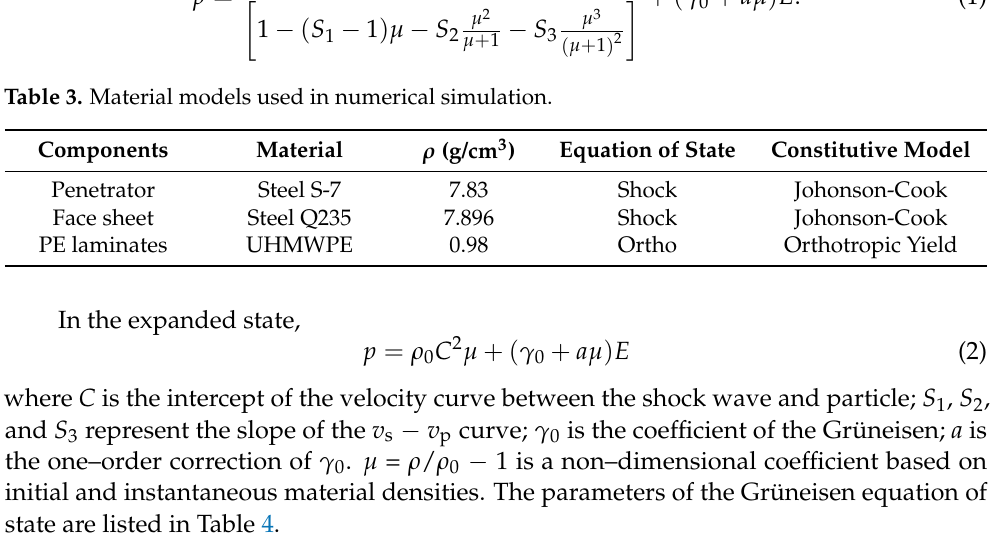
Table 4. EOS parameters of S-7 and